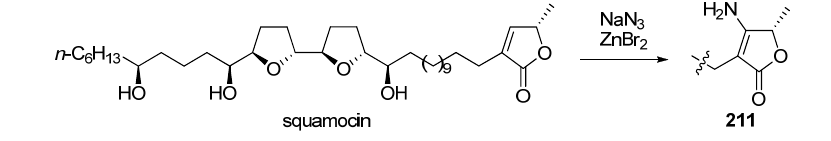
Table 1 6. Inhibitory activities of 211 and